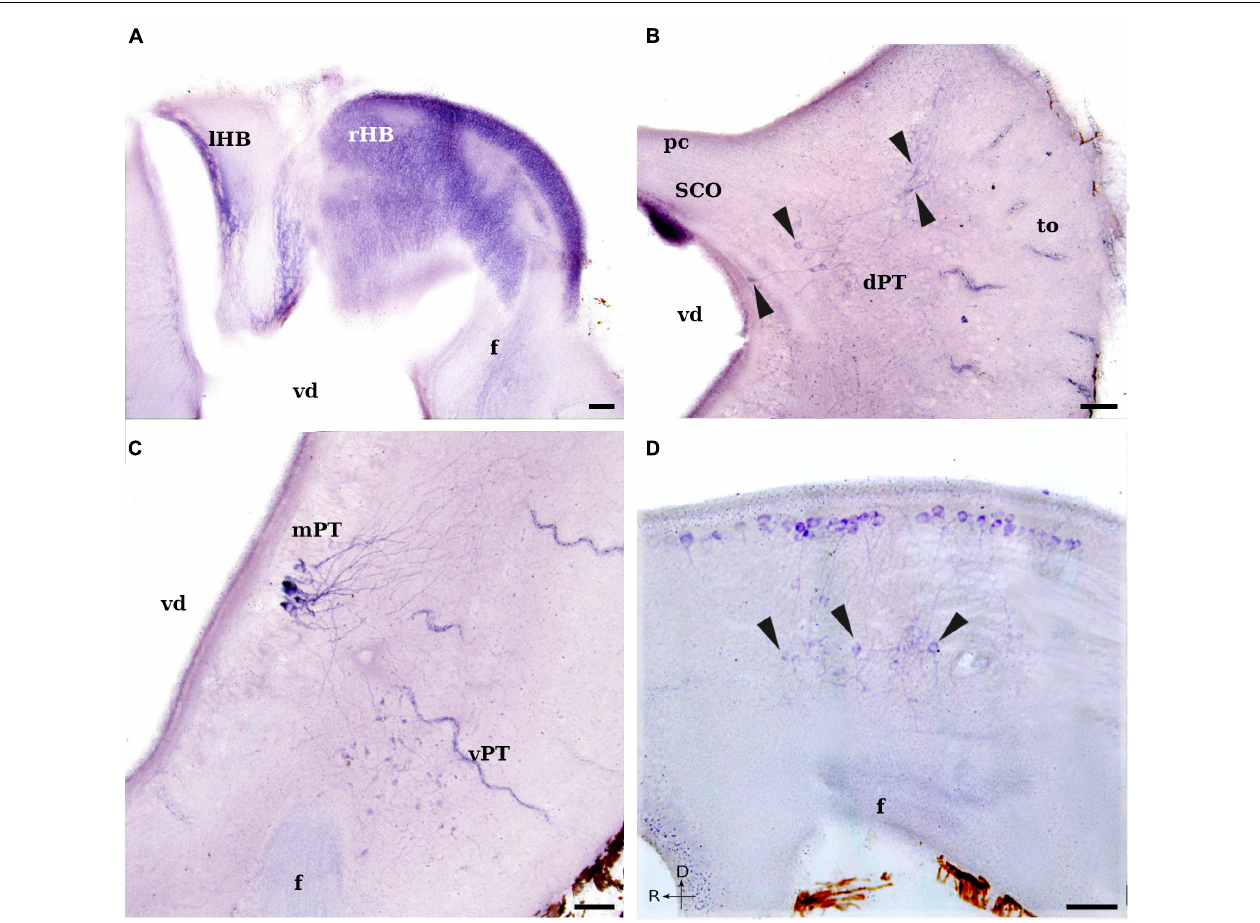
FIGURE 4 | Photomicrographs showing NADPH-d positive cells and fibers in the diencephalon of L. fluviatilis . (A) Transverse section through the habenula showing numerous and small NADPH-d positive cells in the right part (rHB; the largest part), whereas only some positive fibers are present in the left part (lHB). Some positive fibers are also observable in the fasciculus retroflexus (f). (B) Transverse section showing a strong NADPH-d staining in the subcommissural organ (SCO), as well as some positive cells (arrowheads) in the dorsal pretectal nucleus (dPT). Note the area of distribution of the labeled cells and their dendrites. (C) Transverse section showing strong NADPH-d positive cells in the medial pretectal nucleus (mPT) and more weakly stained cells in the ventrolateral pretectal nucleus (vPT). Note also the presence of weakly labeled fibers in the fasciculus retroflexus (f). (D) Sagittal section showing several NADPH-d labeled periventricular cells covering the rostrocaudal extension of the ventral diencephalon. Some ventral displaced cells (arrowheads) are located dorsally to the fasciculus retroflexus (f). Medial and rostral directions are oriented to the left in transverse and sagittal sections, respectively. For abbreviations, see list. Scale bar = 25 µ